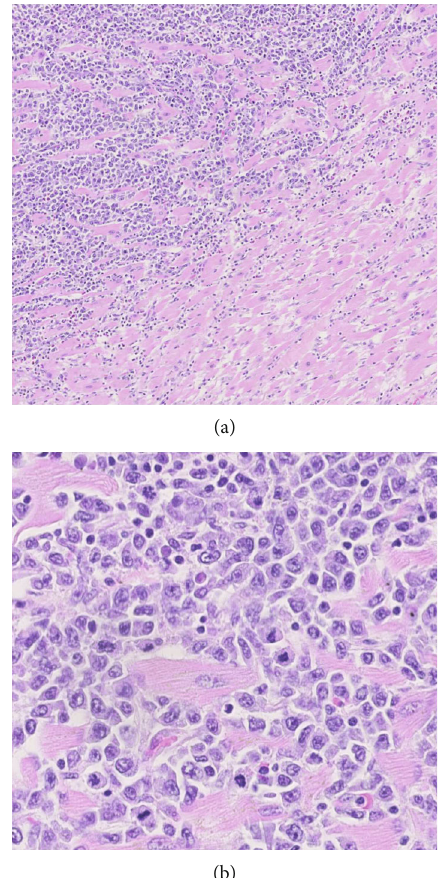
Figure 2: Histologic sections of the heart showed in fi ltration by mitotically active, pleomorphic cells, with associated myonecrosis. (a) and (b)H&E (hematoxylin and eosin) at 10 × and 40 × magni fi cation,